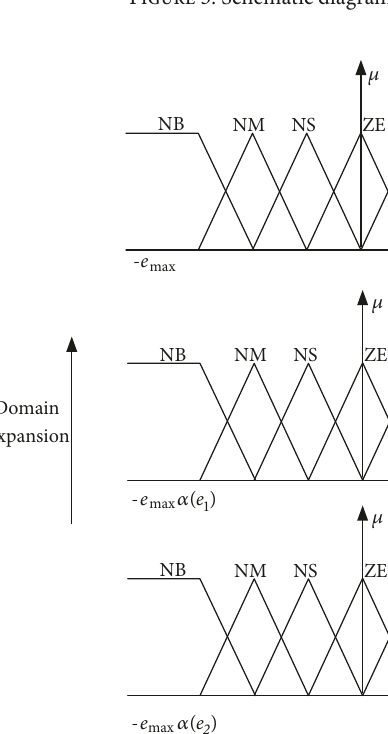
Figure 3: Schematic diagram of the MPGA algorithm.